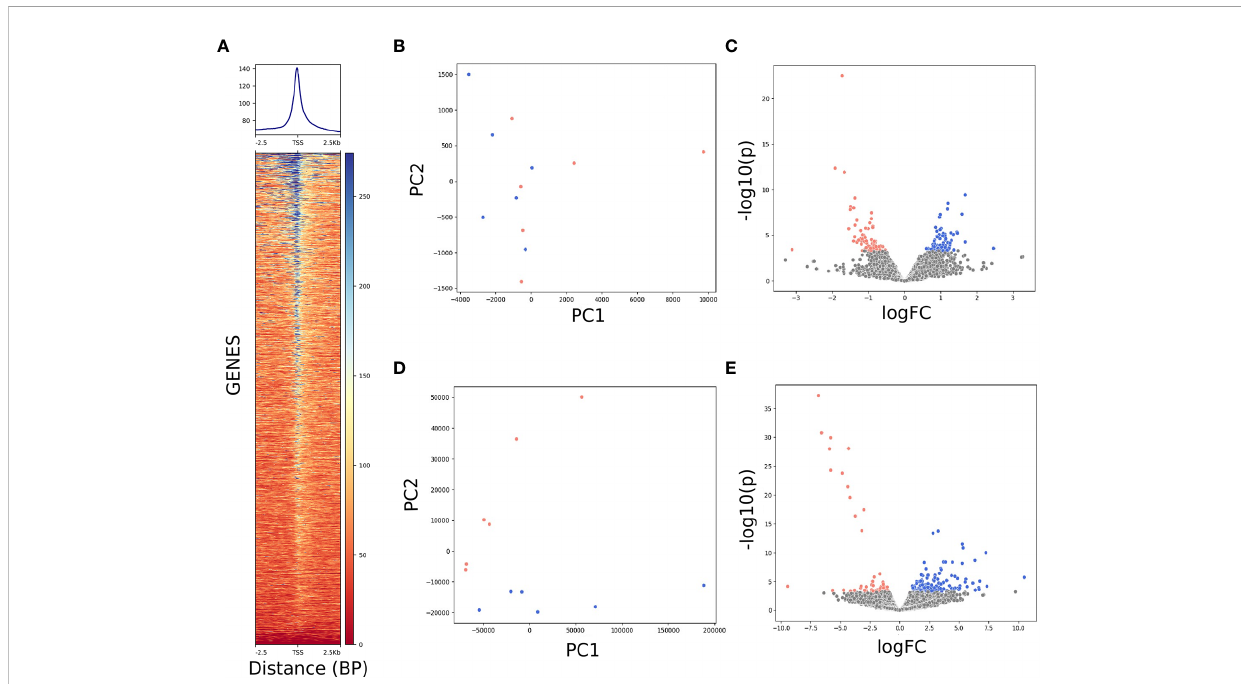
FIGURE 3 Next generation sequencing data analysis. (A) ATAC-seq alignment displayed an expected enrichment in reads around transcription start sites. (B – E) Blue represents DACR and DEGs upregulated in 19Q4-13, while pink represents those upregulated in Tx430. (B) ATAC-seq read counts in peaks did not appear to show clustering between Tx430 and 19Q4-13. (C) Volcano plot of ATAC-seq peaks. (D) RNA-seq expression data showed clustering between 19Q4-13 and Tx430 using the fi rst 2 principal components. (E) Volcano plot of RNA-seq